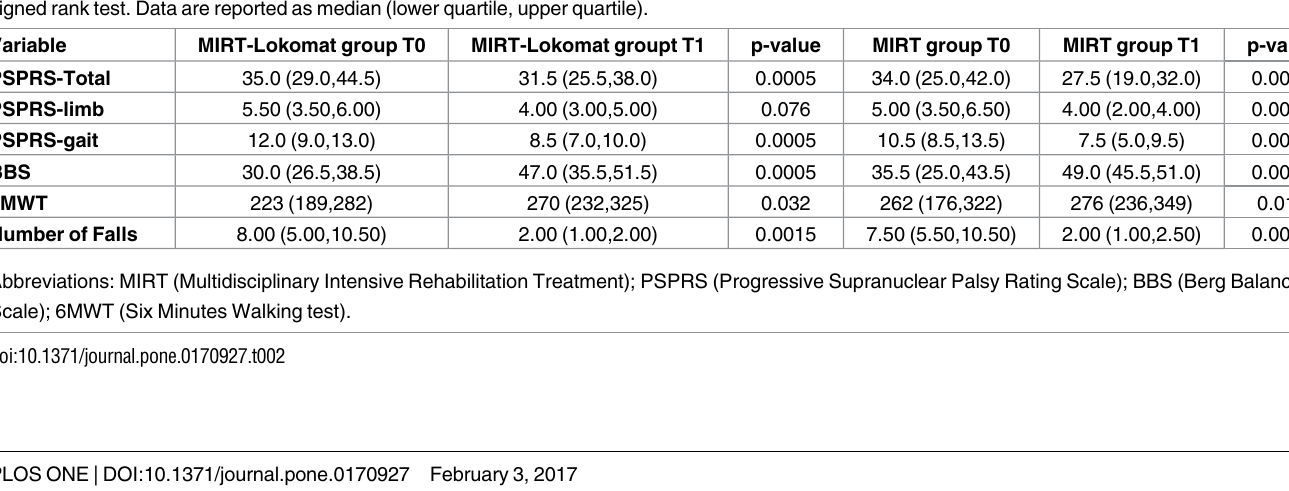
The demographic and clinical characteristics of patients assigned to MIRT group and MIR- T-Lokomat group are reported in Table 1. No statistically significant differences were observed at baseline between the two groups in any of the different variables. Baseline (T0) and end of treatment (T1) values of outcome variables are reported in Table 2 for both groups. Regarding the number of falls, T0 and T1 correspond to falls incidence in the week preceding the respective observation time. Total PSPRS, PSPRS-gait, BBS, 6MWT and number of falls improved significantly by the end of the training programs in both groups. The corresponding effect sizes (standardized differences) were: -0.6, -1.5, 1.2, 0.5, -2 for MIR- improved significantly only in the MIRT group (p = 0.0020, effect size = -0.7). Finally, Table 3 reports the difference (discharge-admission) of the outcome variables for MIRT-Lokomat group and MIRT group. A significant difference was observed only for total PSPRS (p = 0.047), indicating a slightly better improvement for patients in the MIRT group. No difference was revealed for the other outcome variables, indicating that the effect of reha- bilitation was similar in both groups.